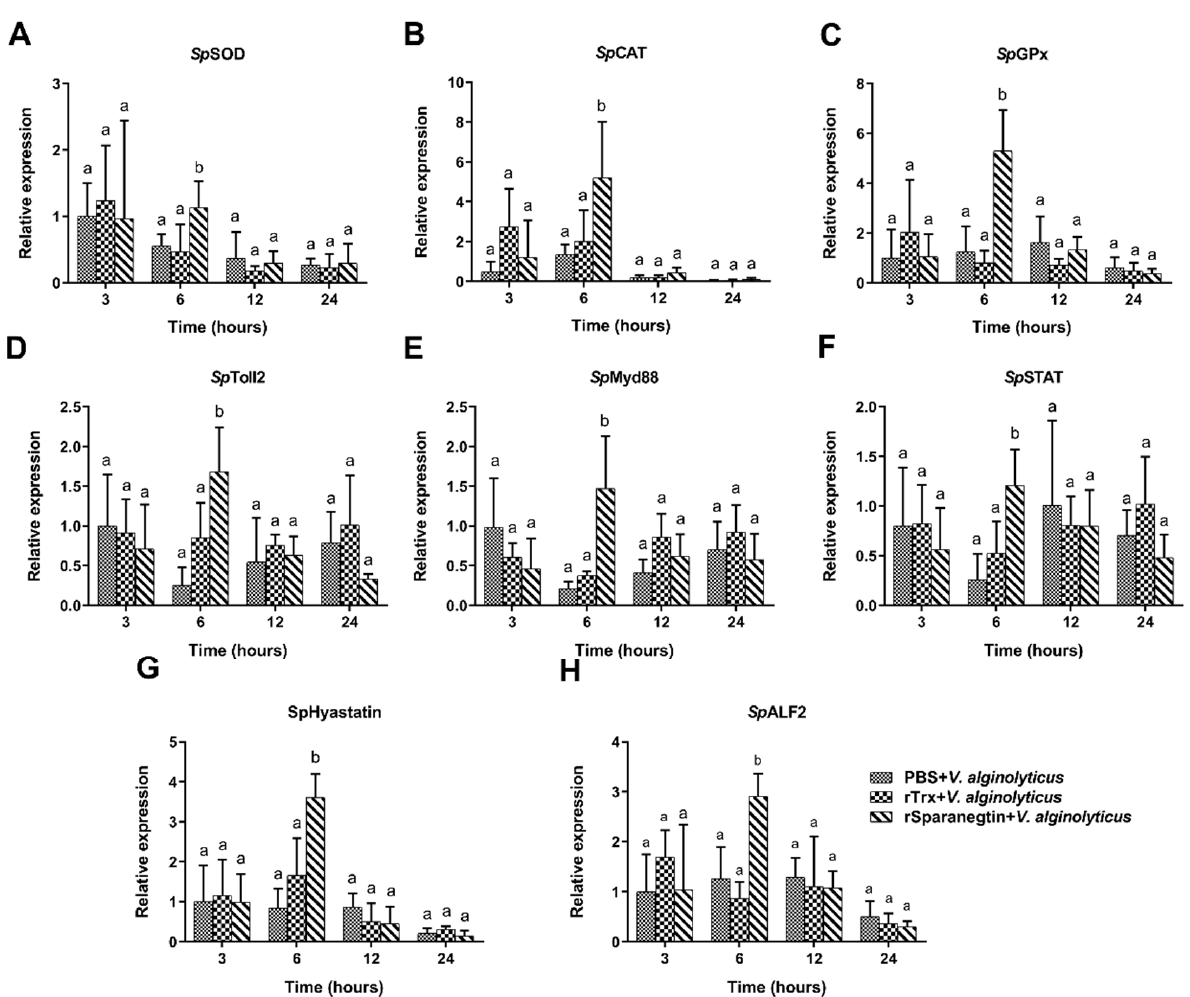
Figure 6. rSparanegtin effects on the V. alginolyticus infection-mediated immune gene expression profiles in S. paramamosain. Crabs were divided into PBS + V. alginolyticus , rTrx + V. alginolyticus , and rSparanegtin + V. alginolyticus groups. The expression levels of Sp SOD, Sp CAT, Sp GPx, Sp Toll2, Sp Myd88, Sp STAT, Sp ALF2, and SpHyastain ( A – H ) were evaluated using qPCR at 3, 6, 12, and 24 h post-injection. Each bar represents the means ± SD ( n = 5). The same letters (a–b) indicate no significant difference between groups, and different letters indicate statistically significant differences between groups ( p < 0.05) as calculated by one-way ANOVA followed by Tukey’s test. It was noted that only the means at each time point were compared for the denotation with the letters, whereas the means at different time points could not be compared with one another.